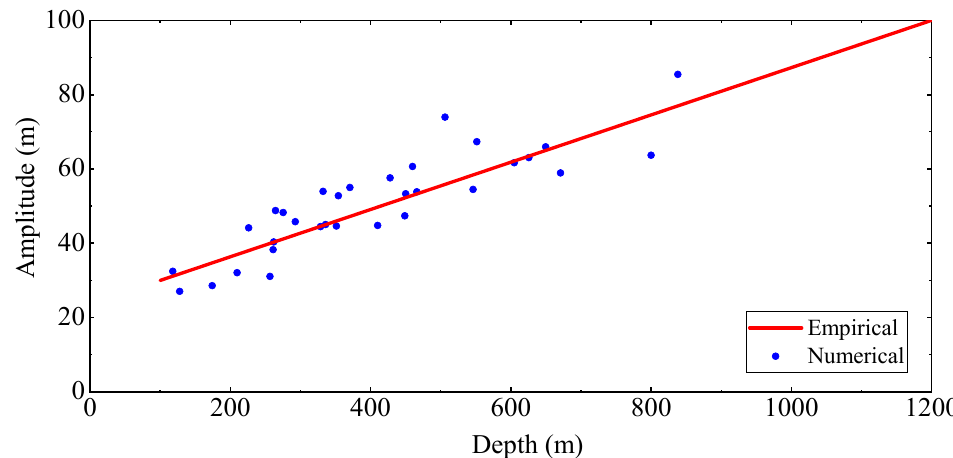
Figure 5. Relationship between the amplitude and the water depth.